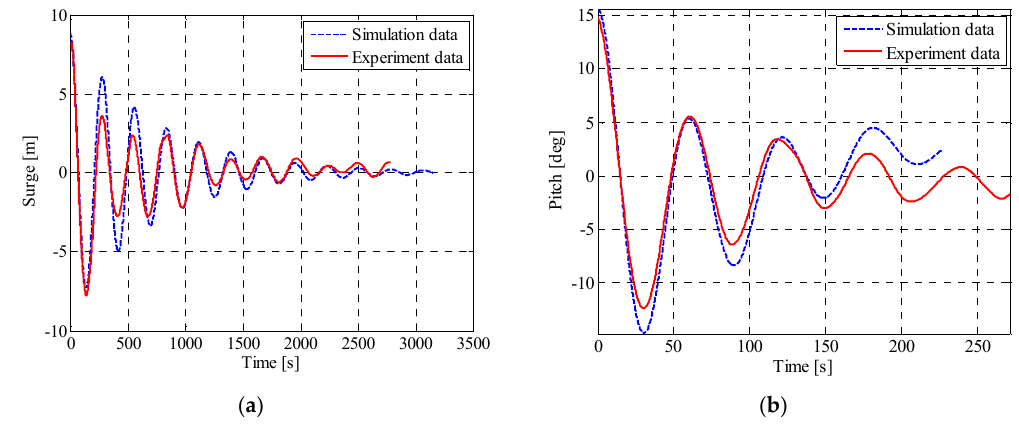
Figure 9. ( a ) The comparison of the surge free ‐ decay time histories of the modified numerical simulation and the wave tank test; ( b ) The comparison of the pitch free ‐ decay time histories of the modified numerical simulation and the wave tank test.